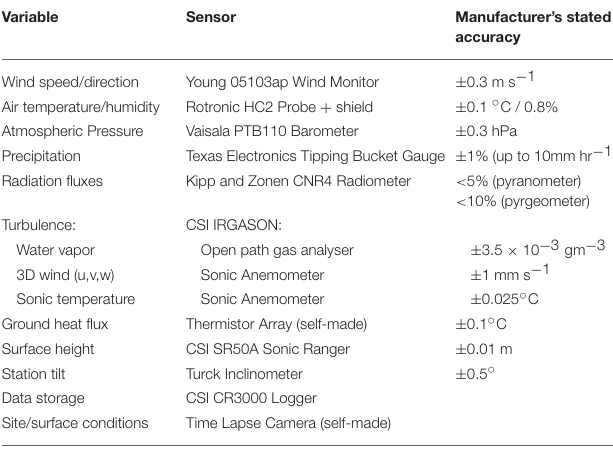
TABLE 1 | Instrumentation used in this